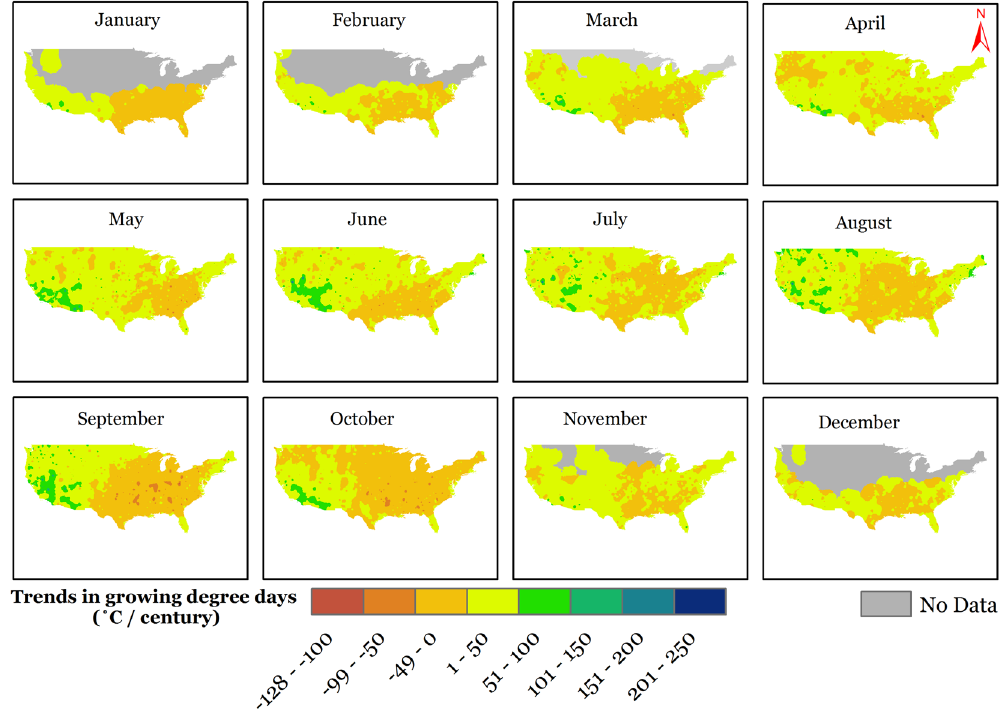
Figure 4. Map showing temporal trends in accumulated growing degree days (AGDD) for different months of the year during the period 1900–2014. We created the maps using ESRI ArcMap 10.4.1 software http://desktop.